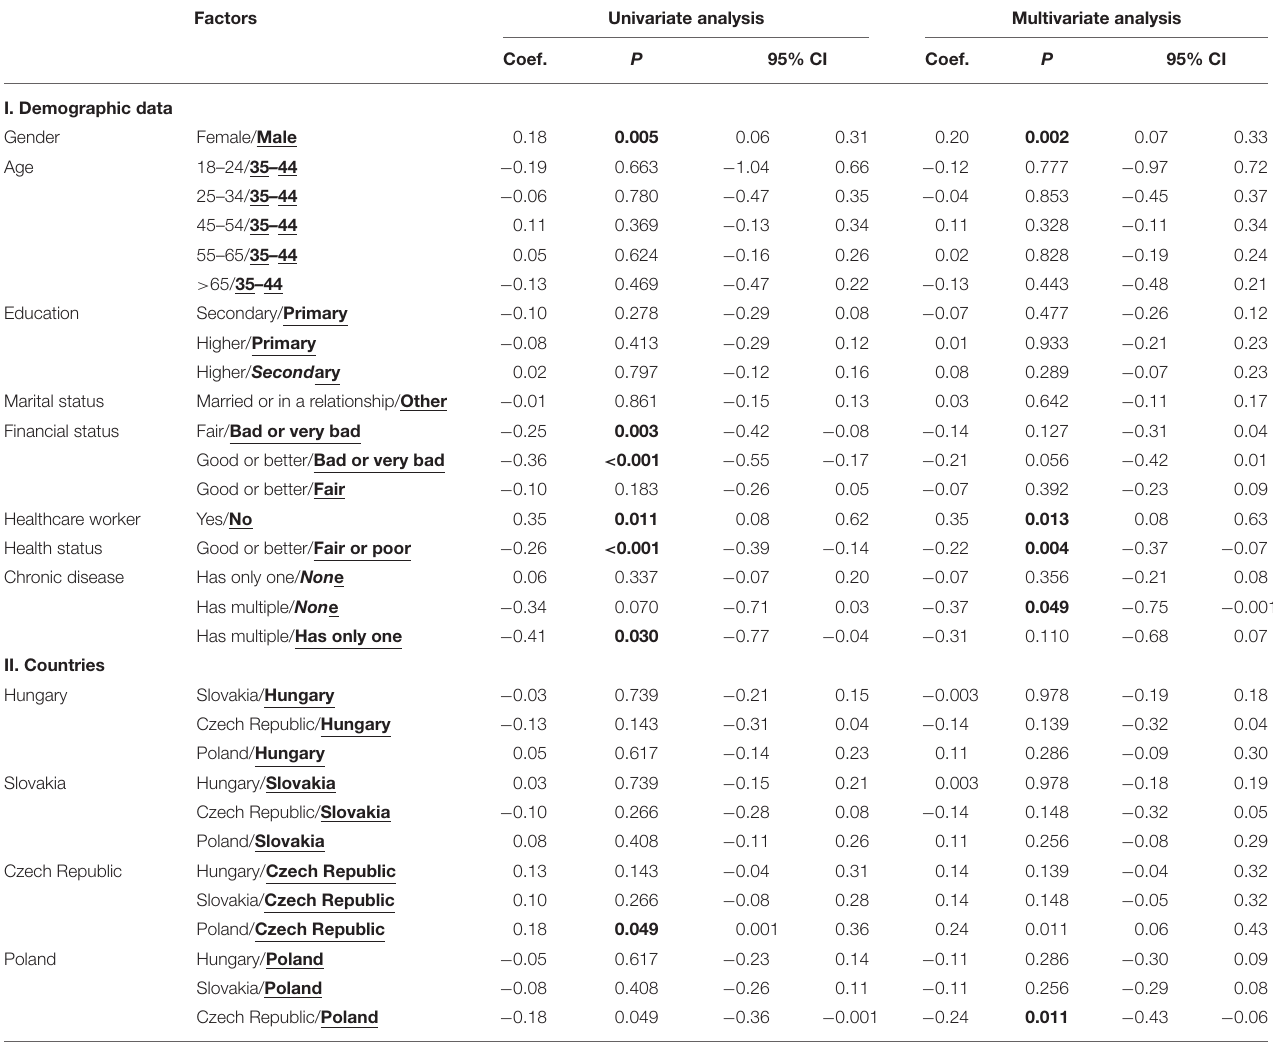
TABLE 4 | Multivariate analysis of concerns within the Visegrad Group countries. Factors Univariate analysis Multivariate analysis Coef. P 95% CI